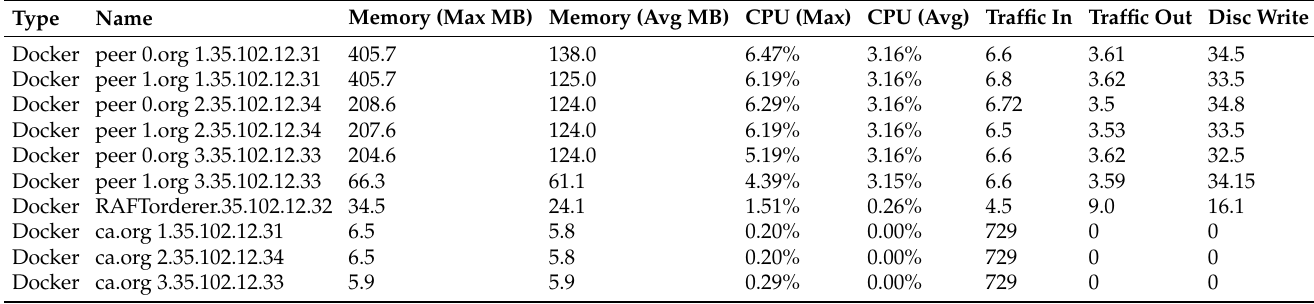
Table 5. Resource consumption after second round